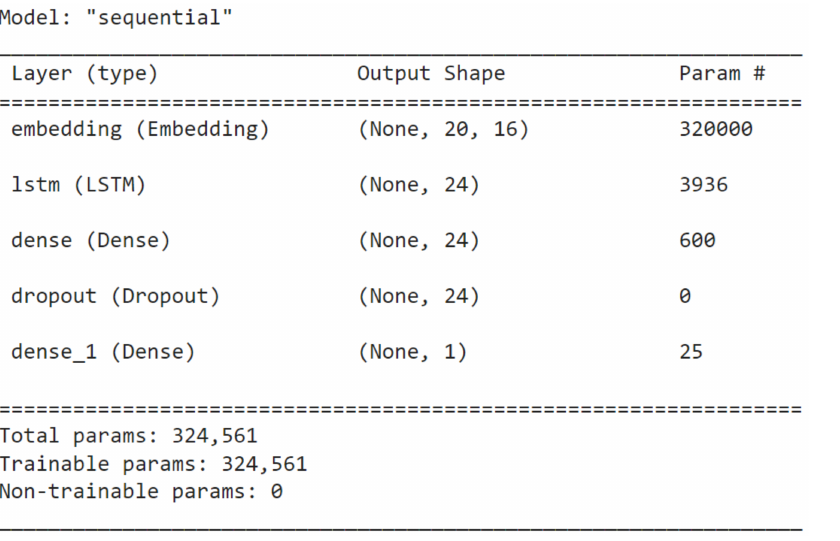
Figure 8. RNN architecture for